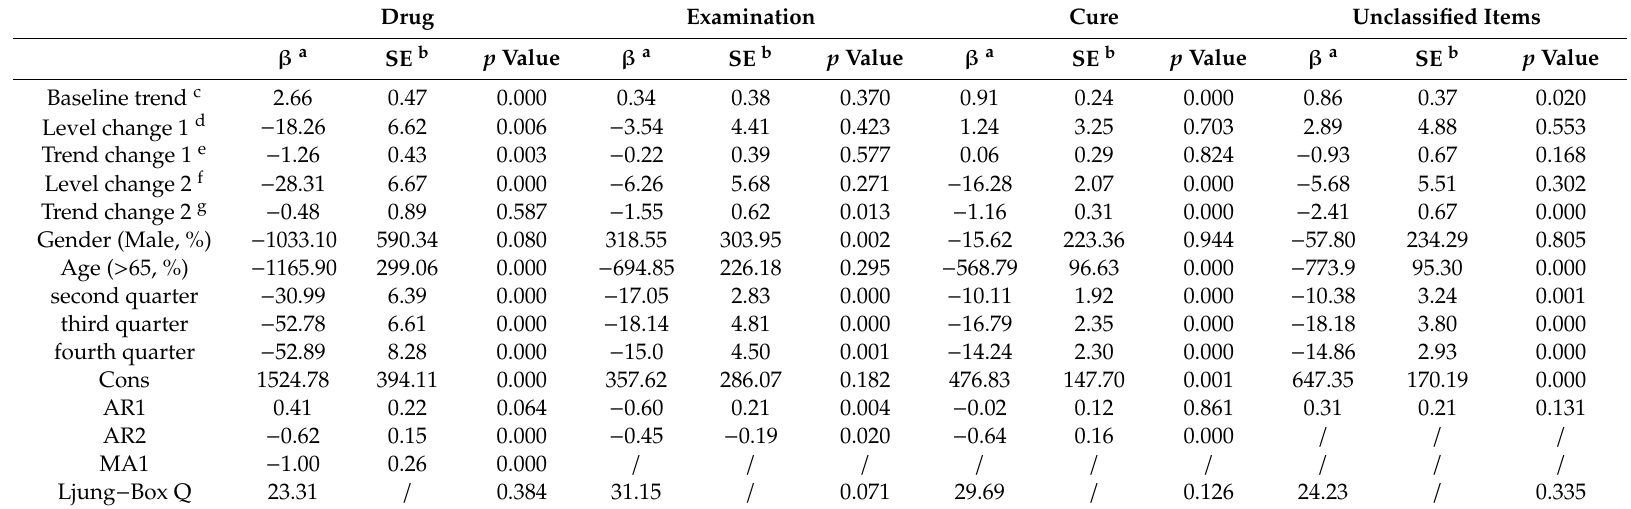
Table 3. Segmented autoregressive integrated moving average analysis of medical expenditure (Million